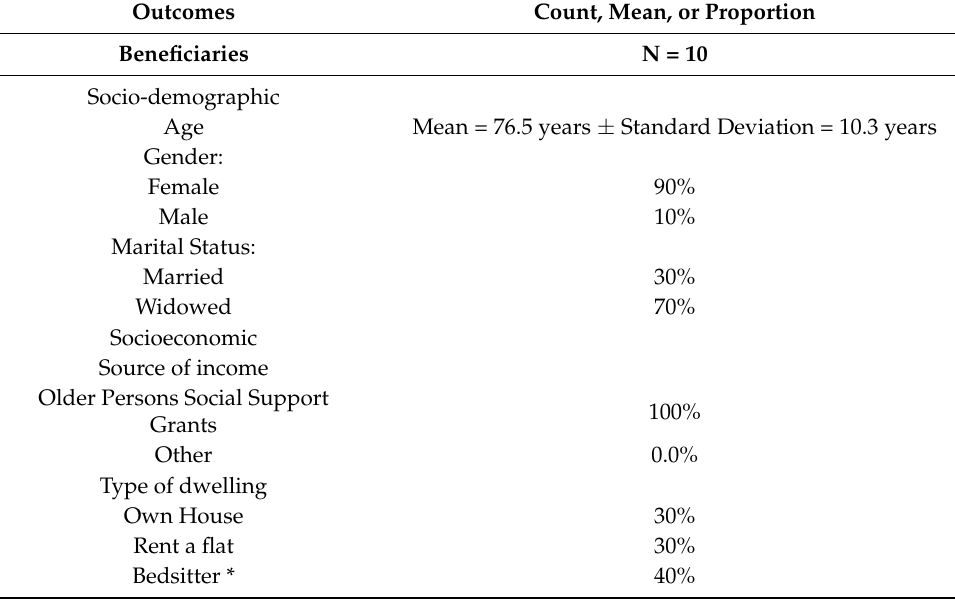
Table 1. The MOWCS beneficiaries and FGDs’ key socio-demographic and socioeconomic outcomes.